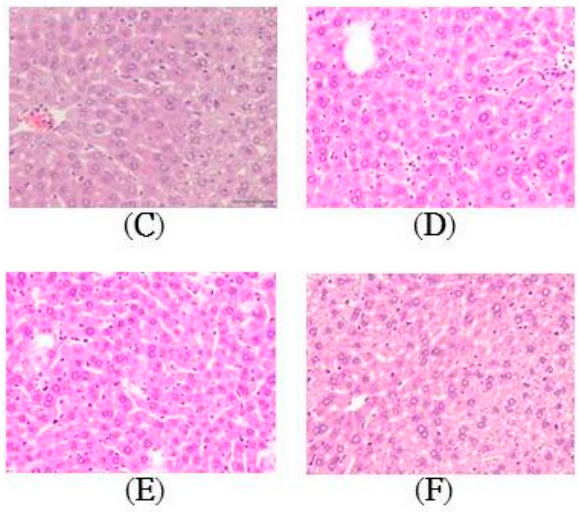
Figure 3. Effects of tormentic acid on APAP-induced liver damage. Sections were stained with H & E (400×) and observed under a light microscope. Control ( A ); APAP (400 mg/kg) ( B ); TA (1.25 mg/kg) + APAP (400 mg/kg) ( C ); TA (2.5 mg/kg) + APAP (400 mg/kg) ( D ); TA (5 mg/kg) + APAP (400 mg/kg) ( E ); NAC (600 mg/kg) + APAP (400 mg/kg) ( F ).